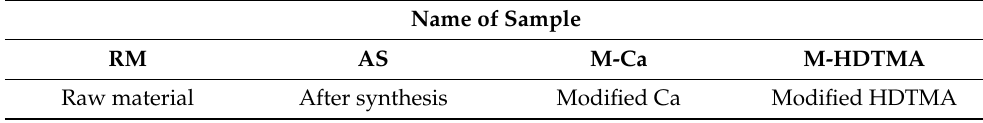
Table 2. Description of samples according to their preparation.